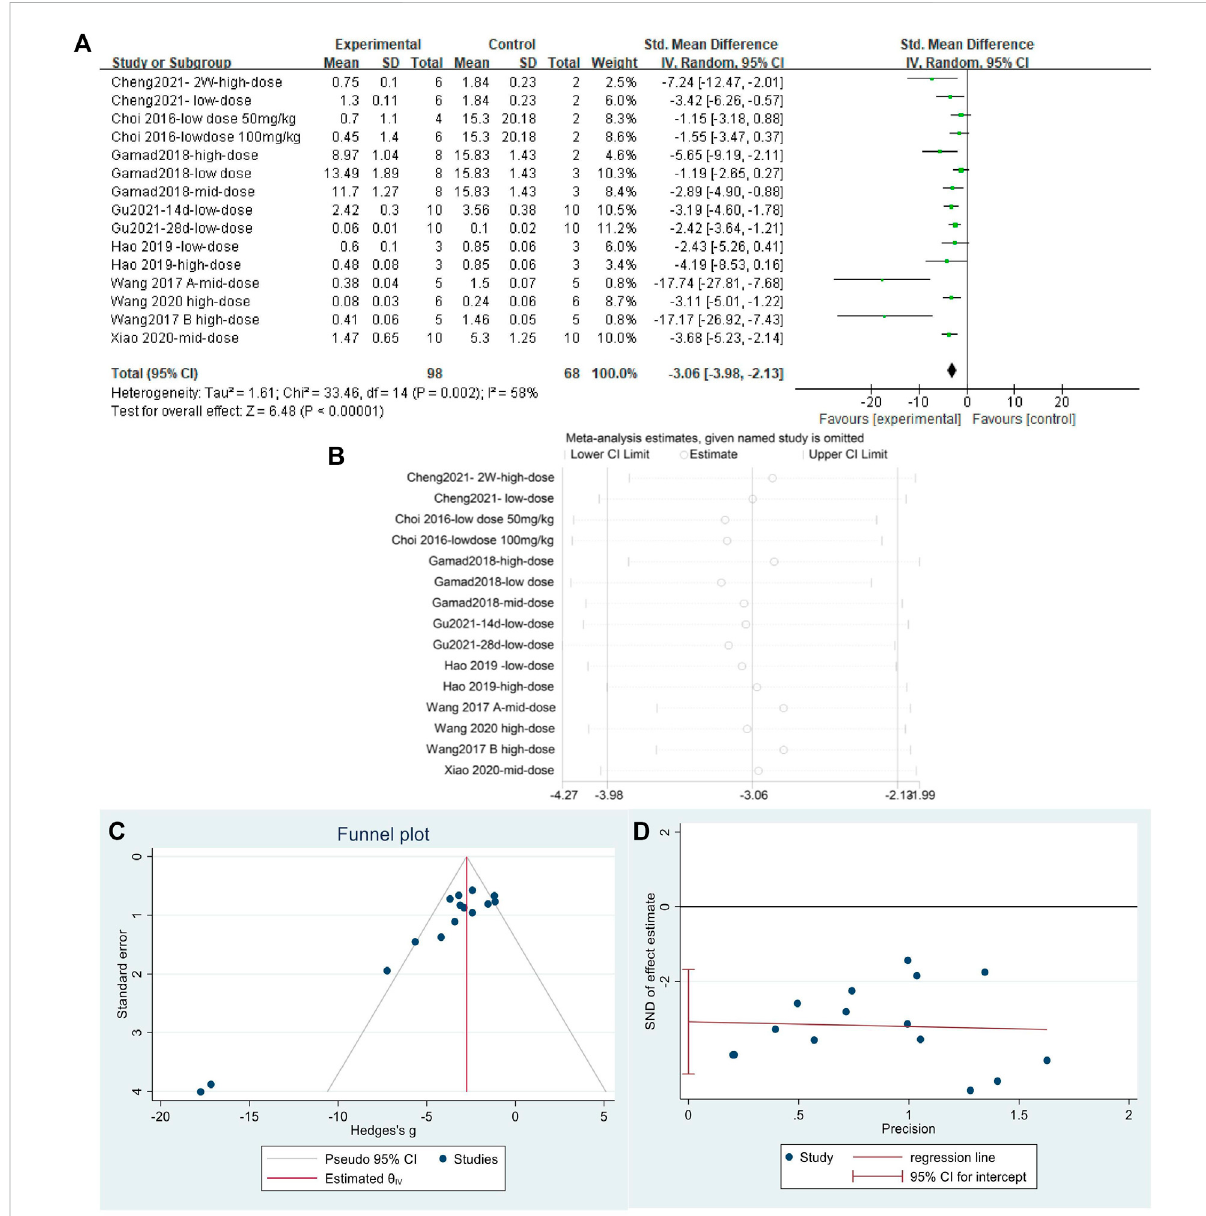
FIGURE 8 Effect of MET on collagen I in lung tissues of PF animals. (A) Forest plot of collagen I; (B) Sensitivity analysis of collagen I; (C) Funnel plot of collagen I; (D) Egger ’ s test for collagen I.